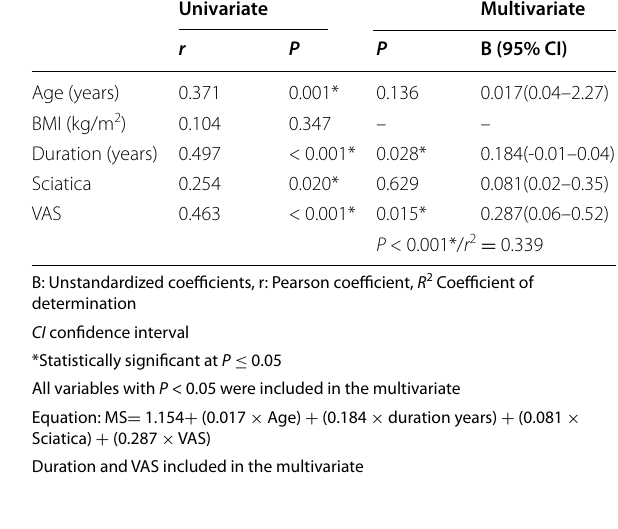
Table 4 Univariate and multivariate linear regression analysis for the parameters affecting multifidus muscle degeneration score